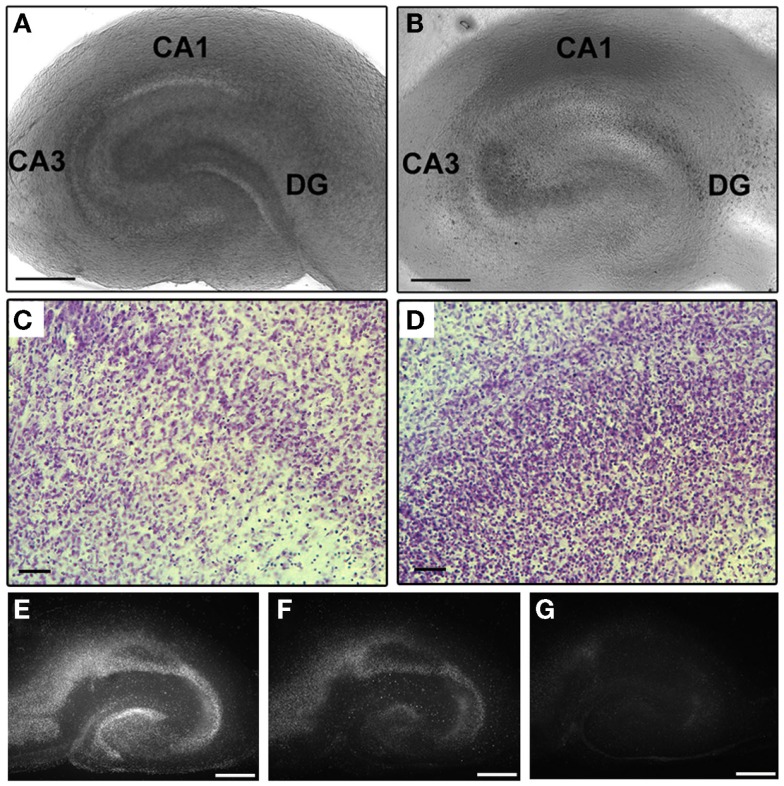
Preservation of OHCs’ structural organization during culturing period. (A) Light micrograph of an acutely dissected OHC. (B) Same OHC as in (A) demonstrates well preserved CA1, CA3, and DG hippocampal regions at 8 DIV. Higher magnification of CA1 (C) and DG (D) regions of cresyl violet-stained OHC at 8 DIV also illustrate intact hippocampal cytoarchitecture. Serial imaging of PI-stained OHC at 1 (E), 5 (F), and 8 (G) DIV demonstrates recovery of slice from procedure-related cellular degeneration. Scale bars (A,B) 500 μm; (C,D) 50 μm; (E–G) 500 μm.